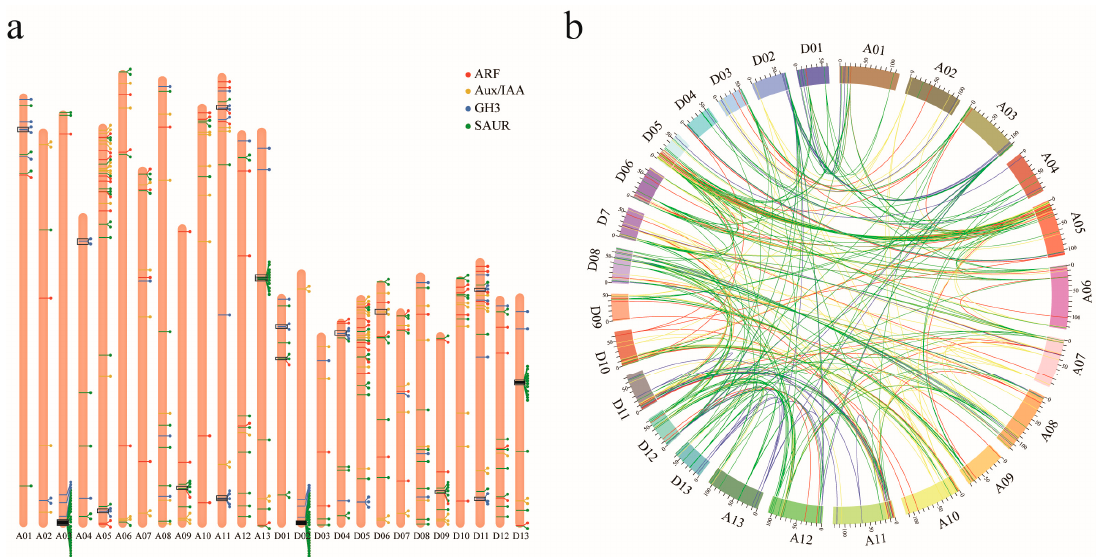
Figure 2. Chromosomal distribution ( a ) and collinearity ( b ) of the identified ARF , Aux/IAA , GH3 , and SAUR genes in upland cotton indicated gene duplications. ( a ) Genes were displayed by striping on chromosomes, circle points were labeled at the end of stripes to make a clearer distinction between adjacent genes from each other. ARF , Aux/IAA , GH3 , and SAUR genes are represented by red, yellow, blue, green stripes and labels, respectively. Tandem duplicate genes were surrounded by black rectangles to represent tandem duplication gene sets. ( b ) Chromosomal segmental duplication regions were analyzed by MCScanX, ARF , Aux/IAA , GH3 , and SAUR homologous gene pairs in segmental duplication regions linked with different color curves (red, yellow, blue, and green, respectively).